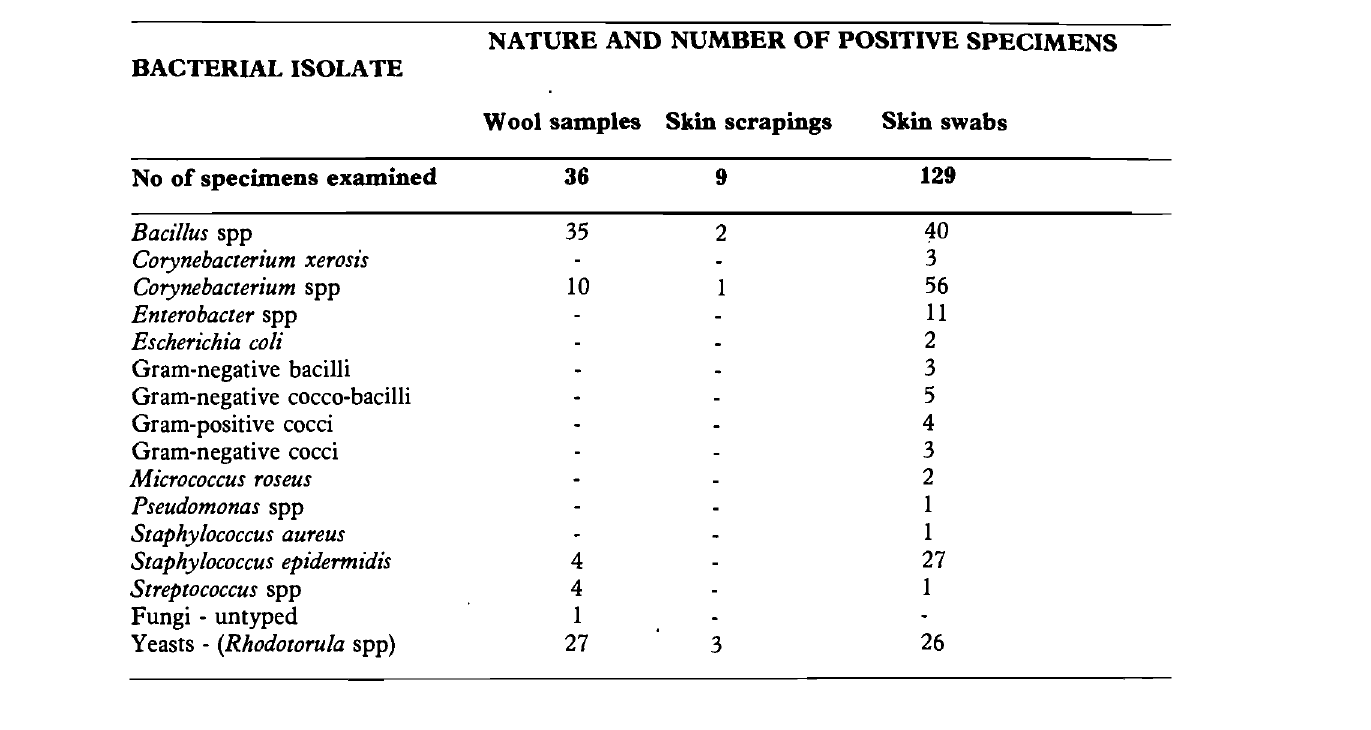
Table 2: Bacteria isolated from sheep -with Bolo disease from the Queensw"~od area NATURE AND NUMBER OF POSITIVE SPECIMENS BACTERIAL ISOLATE Wool samples Skin